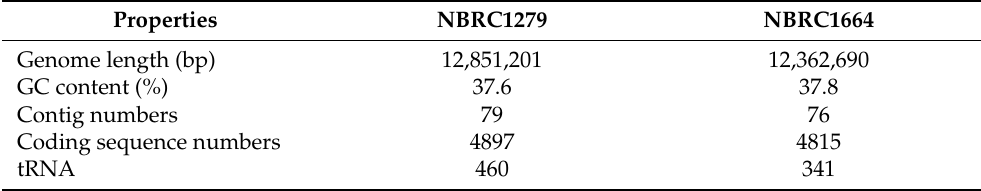
Table 3. Genome features of P. kudriavzevii NBRC1279 and